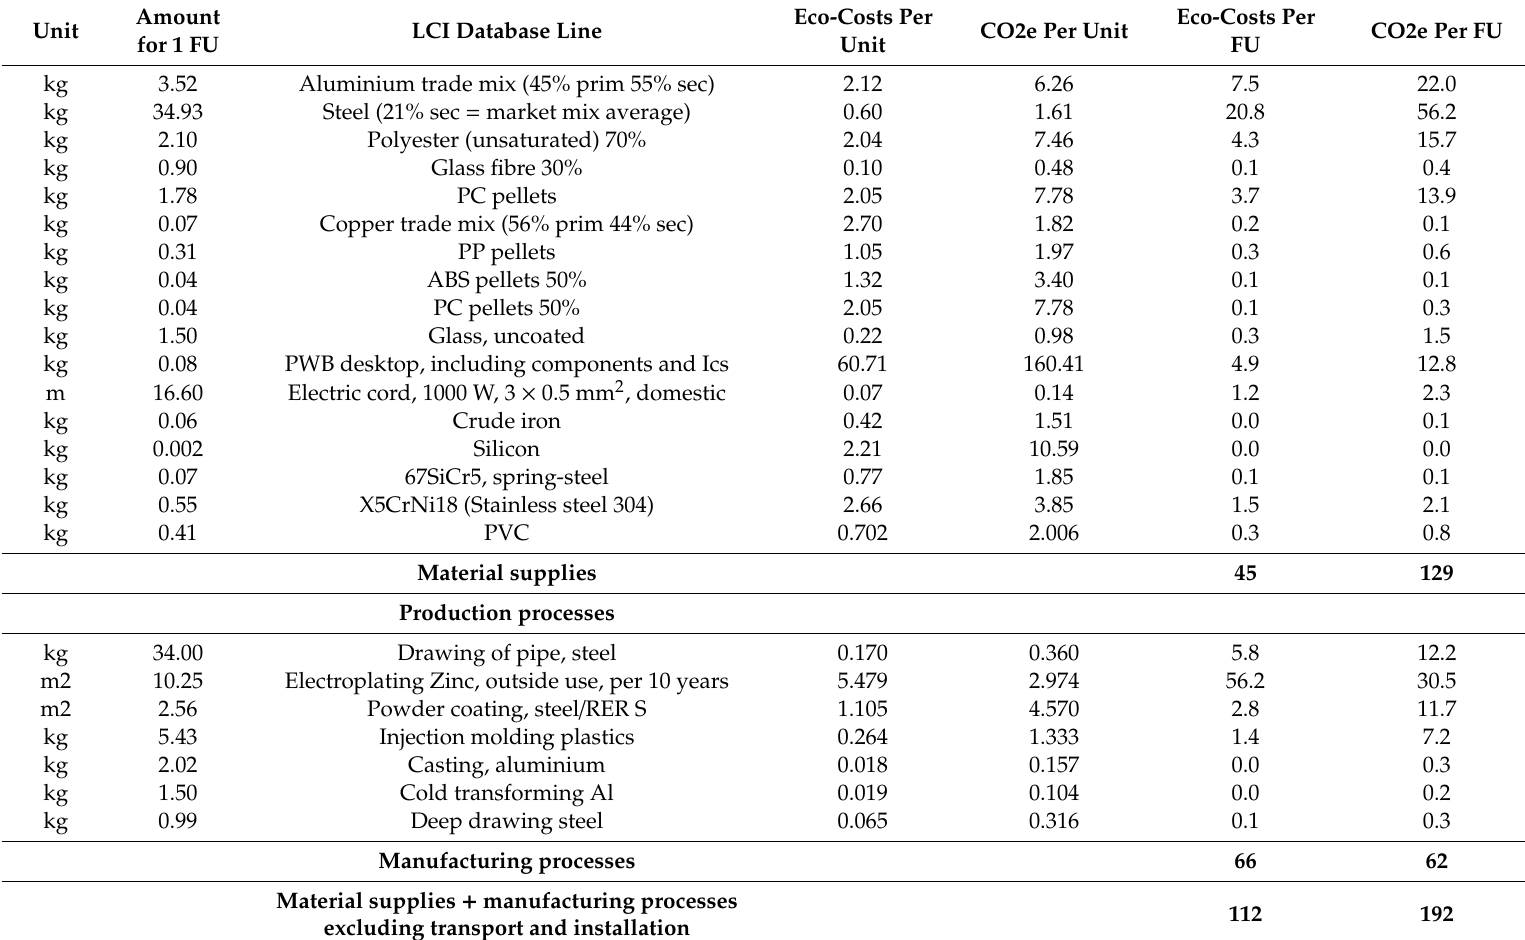
Table 1. An example of an excel LCA table, based on the BOM (bulk of materials) of the base case of a classical lamppost in a street (type ‘Kegeltop’ on a 4 m pole, per